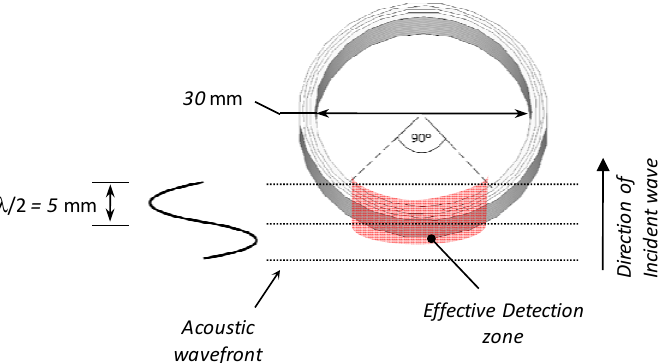
Figure 2. Detail of the effective sensitive zone of the sensor at the desired frequency.